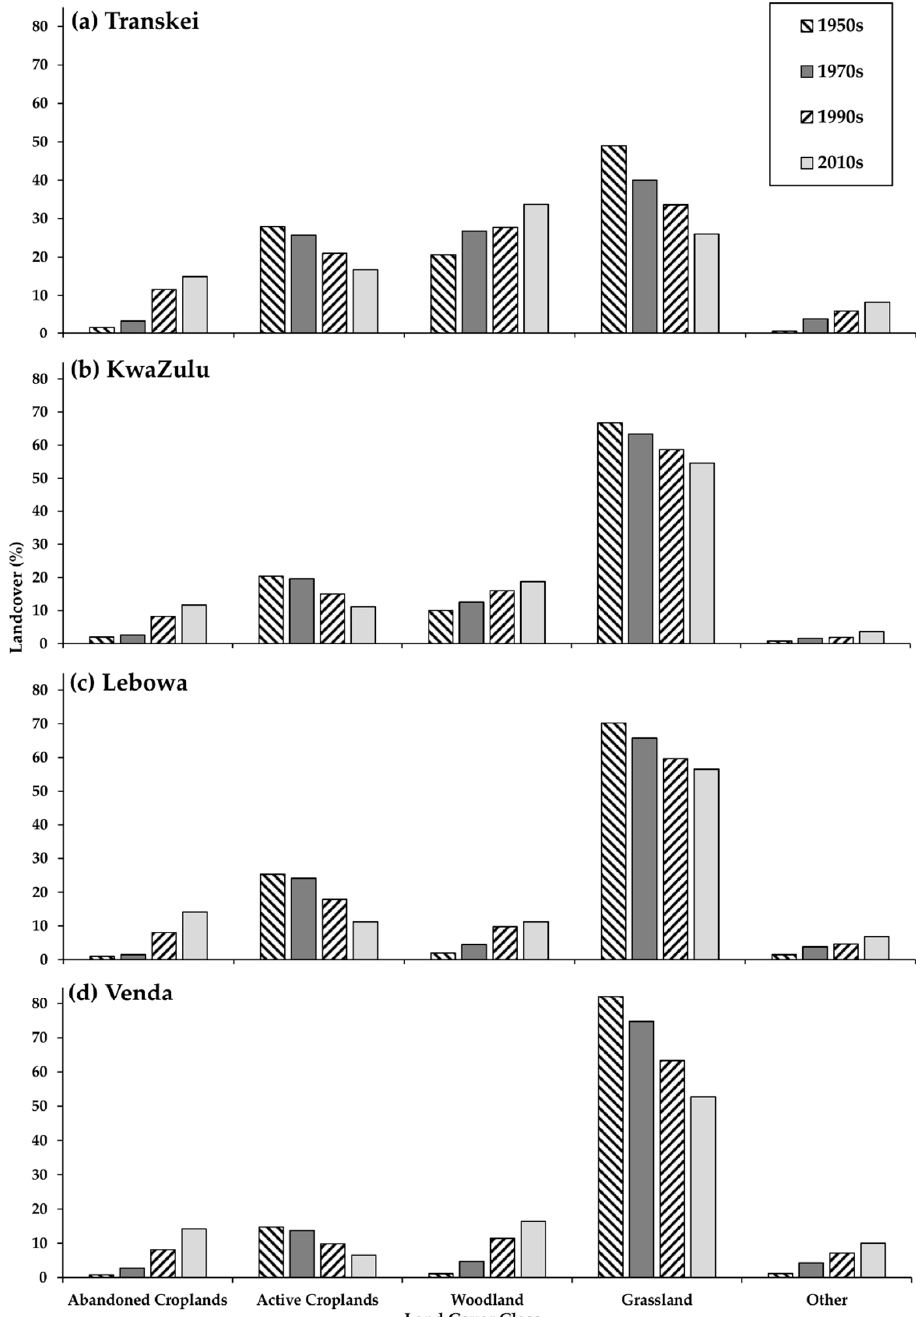
Figure 2. Average land cover (%) in the ( a ) Transkei, ( b ) KwaZulu, ( c ) Lebowa, and ( d ) Venda sites. Land cover classes include: abandoned croplands, active croplands, woodlands (includes forests and shrublands), grasslands, and other (includes infrastructure, rock, and ground).